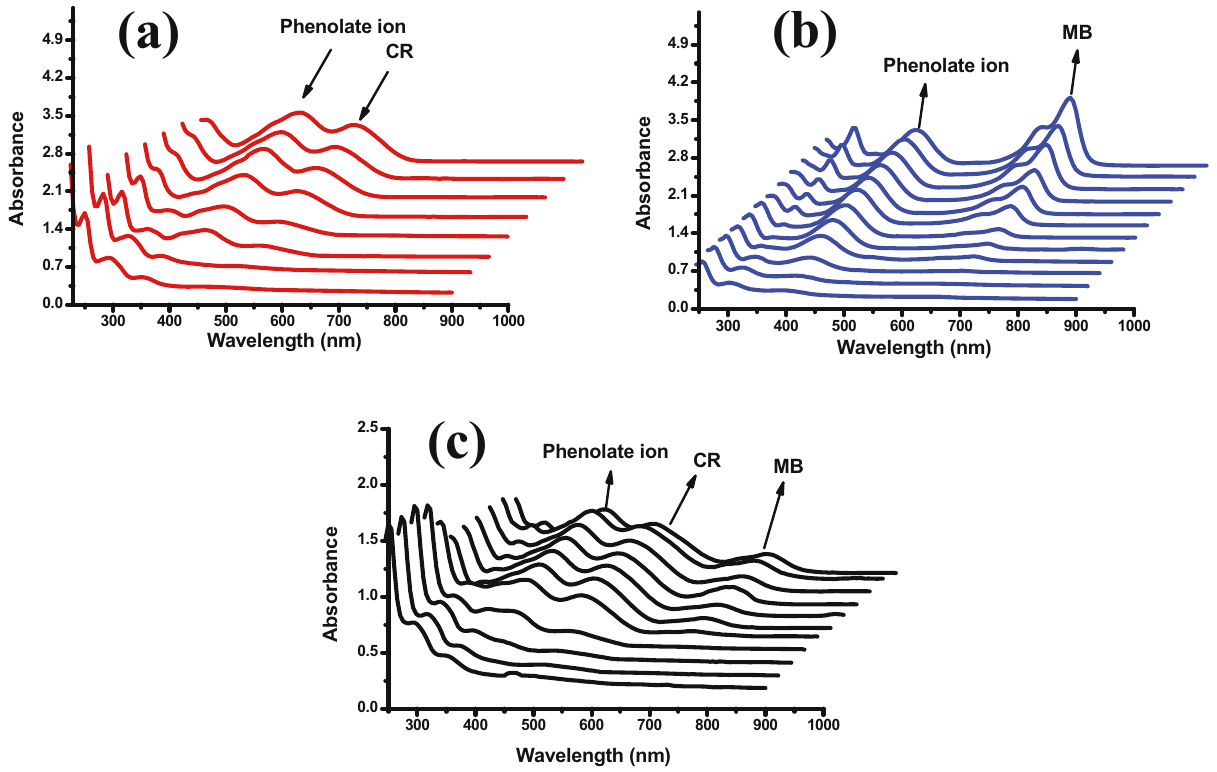
Figure 5: Time - dependent UV - Vis spectrum for the removal of a mixed system of dyes and PNP ( a ) represent the mixed system of CR - PNP degraded in 6 min, ( b ) MB - PNP degraded in 10 min, and ( c ) MB - PNP - CR degraded in 9 min. The results show the selectivity of MB as compared to CR and